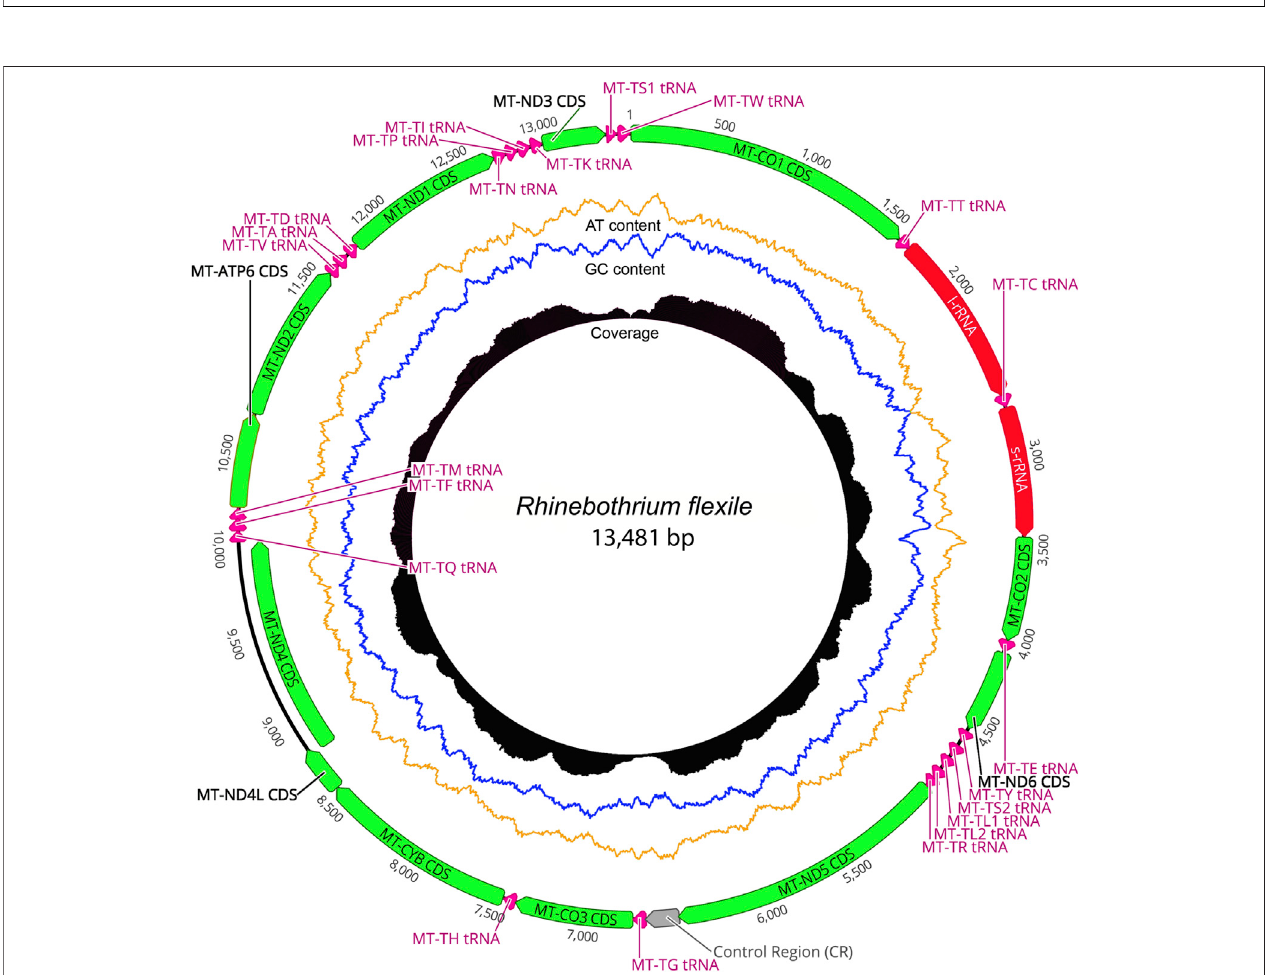
FIGURE 3 | The complete mitogenome map of the Rhinebothrium fl exile — BU006 (GenBank MZ594571), selected to represent the gene organization of the new mitochondrial genomes described. The image was generated with Circleator v1.0.2 (Available at: http://jonathancrabtree.github.io/Circleator/). Grey: control region; green: genes; red: rRNA; pink: tRNA; AT%: yellow; GC%: blue. Coverage (black skyline plot) shows coverage values generated by mapping the reads on the mitogenome sequence with Bowtie2 (Langmead and Salzberg, 2012).